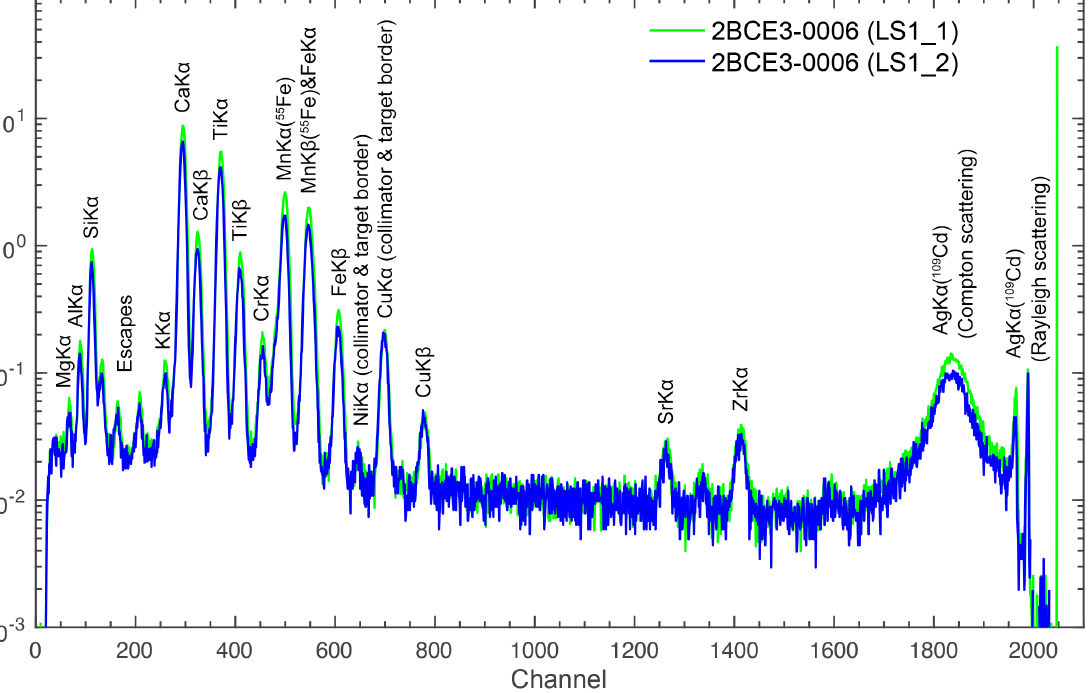
Figure 4. APXS spectra of lunar soil samples (LS1_1 and LS1_2) measured on 24 December 2013 (UTC). NiK α peak is partly from materials in the